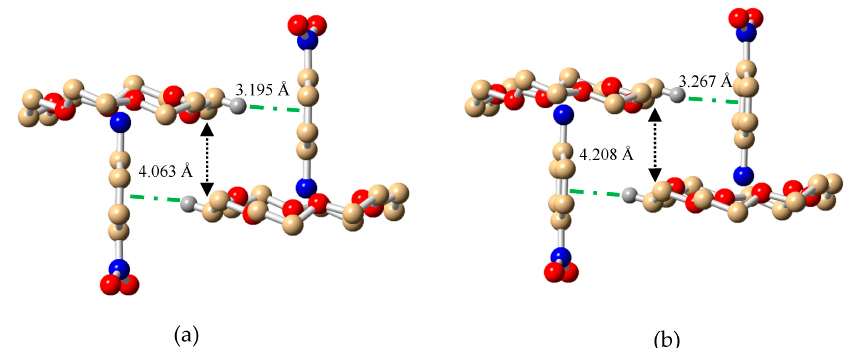
Figure 2. Arrangement of the supramolecular cations in 1 at 100 K ( a ) and 296 K ( b ) viewed in the a+c plane; the dashed lines show the C–H ⋯ π interactions.